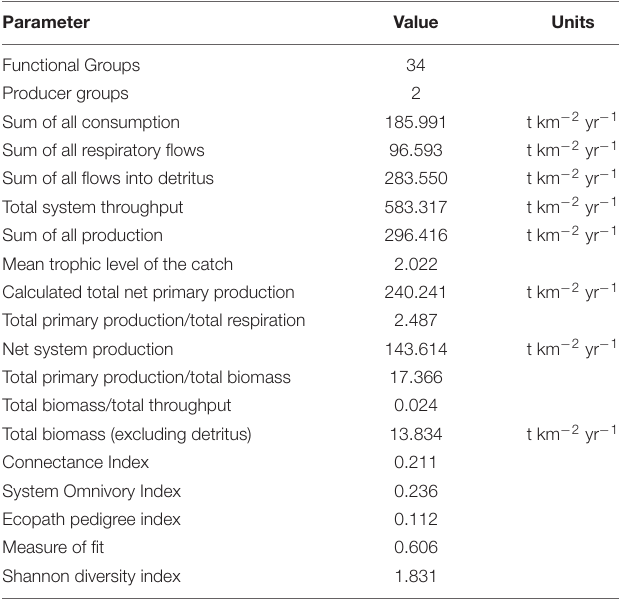
TABLE 1 | Statistics, ecological indicators (Odum, 1971) and flows of the Ecopath